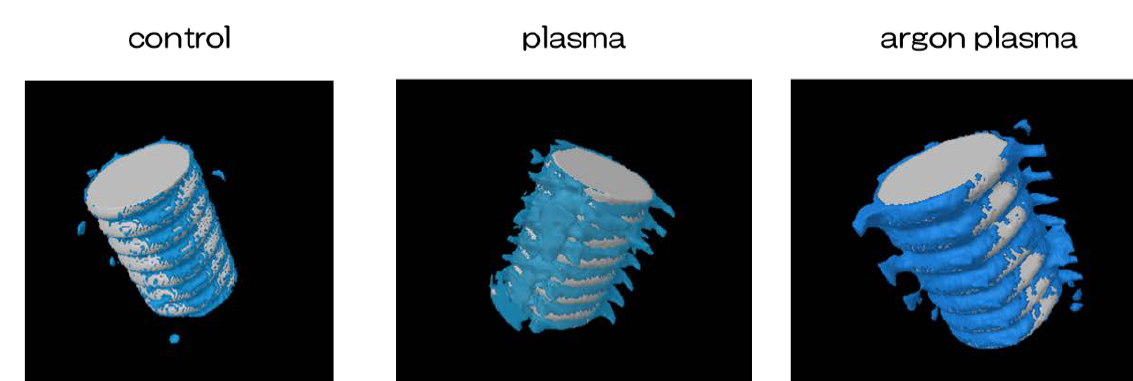
Figure 9. Trabecular microarchitecture was more prominent in the area of the material surface for the test group, than for the control group. White ; implant body, blue ; bone.